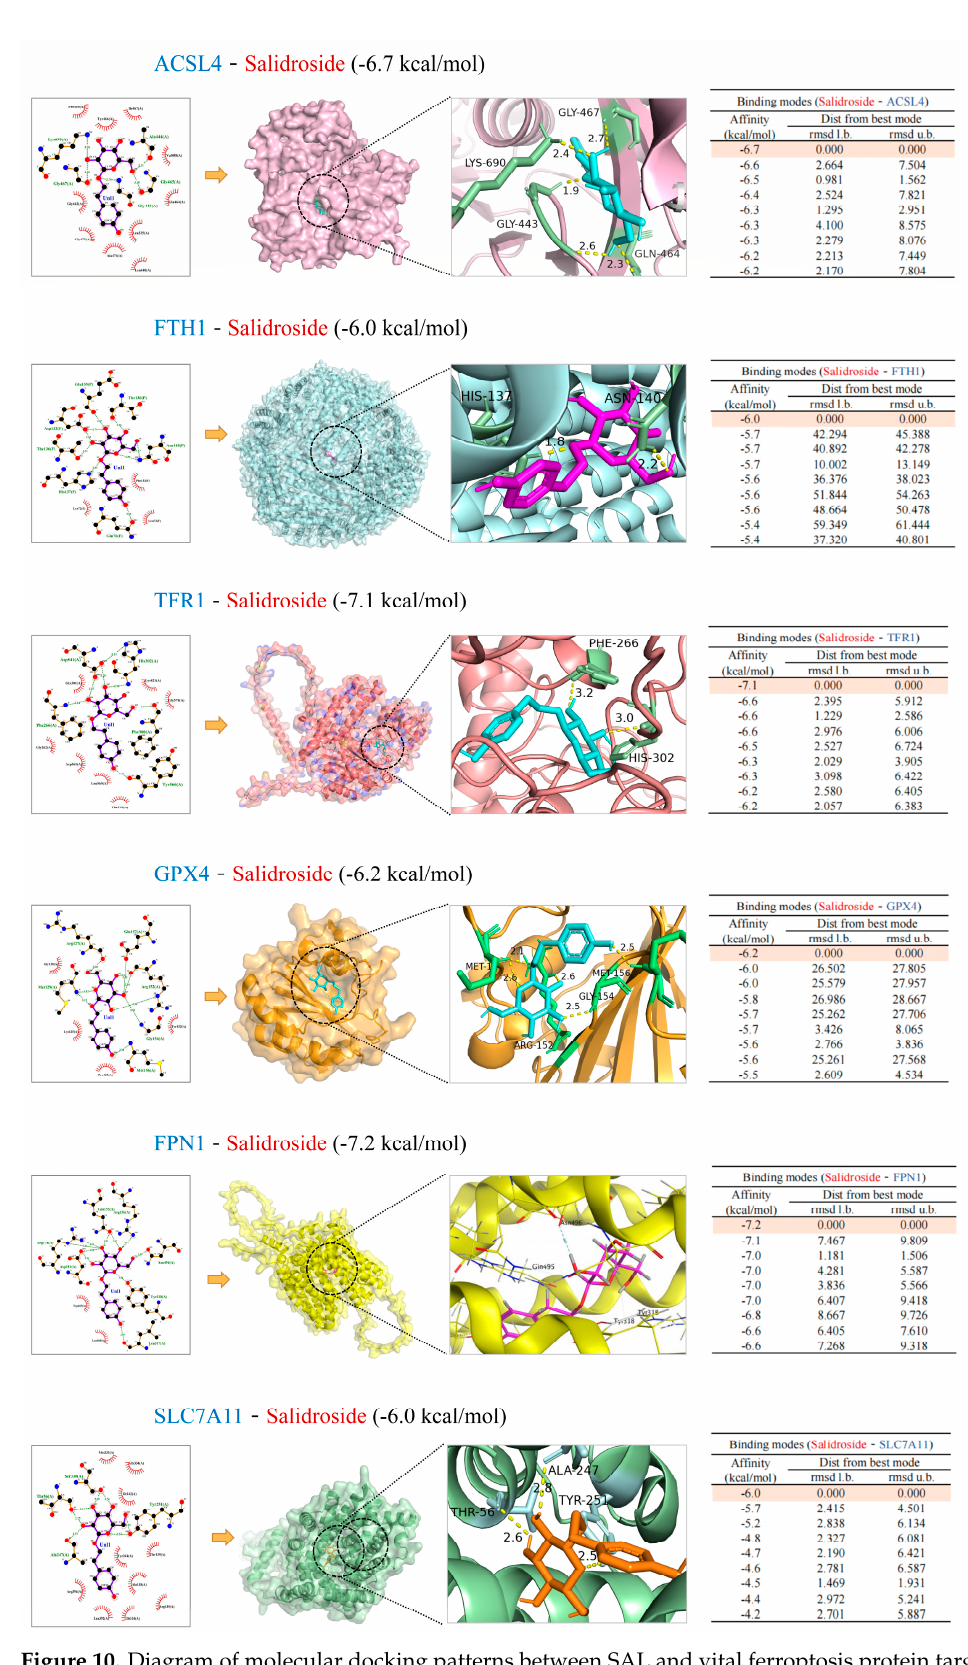
Figure 10. Diagram of molecular docking patterns between SAL and vital ferroptosis protein targets. The docking positions of the binding mode with the best binding energy are shown from global and local perspectives, respectively. The 2D binding modes and detailed docking solutions are